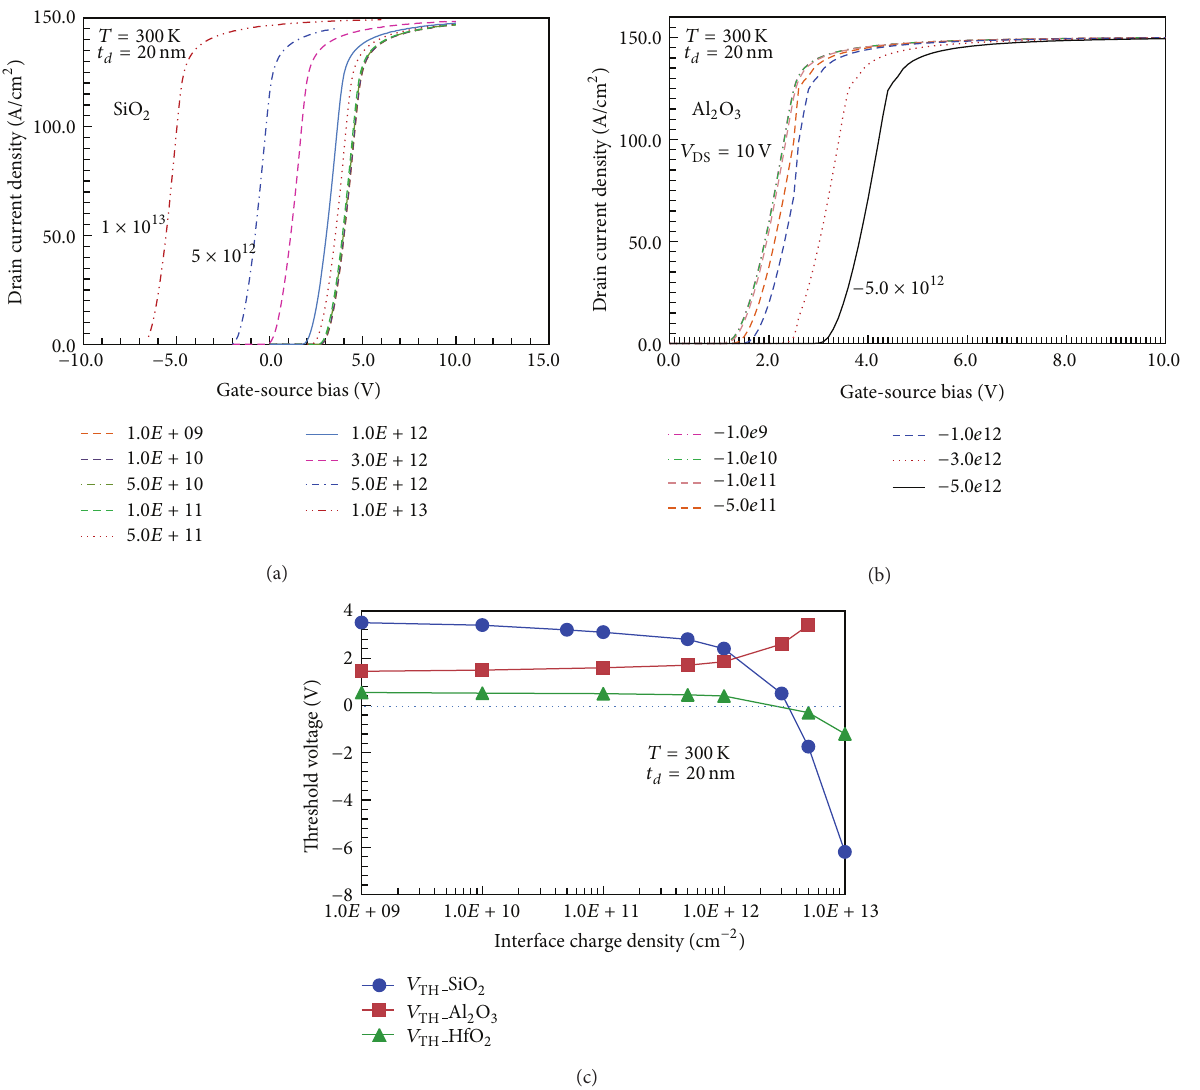
Figure 7: Drain current density as a function of gate-source bias for various interface state densities using SiO 2 as a gate dielectric (a) and Al 2 O 3 as a gate dielectric (b). Threshold voltage shift is also shown for various gate dielectrics as a function of interface state densities (c). Simulations have been performed for 20 nm thick gate dielectric at 300